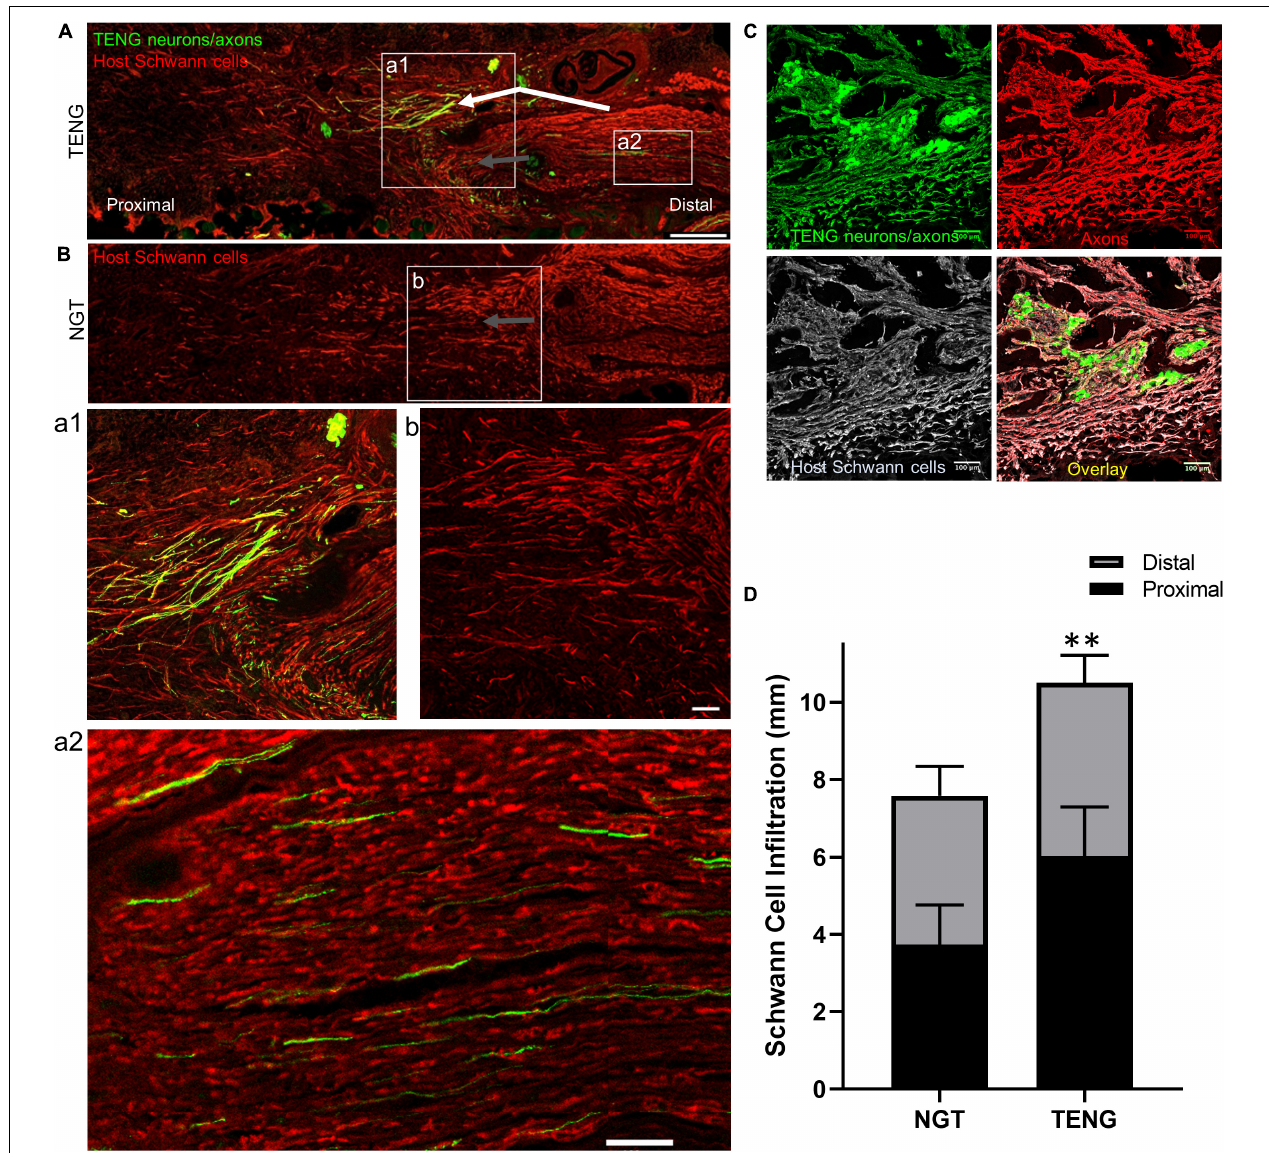
FIGURE 5 | TENGs Direct Host Schwann Cell Infiltration. Longitudinal sections across the graft zone at 2 weeks following repair using TENGs or NGTs. (Aa1) In cases where TENG axons (green) were present off-center (shown in upper half of the boxed section), SC infiltration was markedly directed upward toward TENG axons, indicating that SCs are attracted to TENG axons and alter their migration to infiltrate along TENG axons. (Bb) In NGTs, SCs generally infiltrated linearly from ends, typically observed only in center of NGT (tapered cone). (a2) TENG axons also projected into the distal nerve stump to grow along host SCs. (A,B) Scale bars: 500 µ m. (a1,a2,b) Scale bars: 100 µ m. (C) Host SCs also directly interacted with TENG neurons; scale bar: 100 µ m. (D) Plot of quantified SC infiltration measurements (mean ± standard deviation). SC penetration from the proximal and distal ends was quantified. TENGs significantly increased infiltration of SCs compared to NGTs (** p <